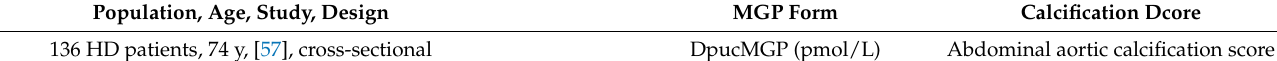
83 patients with CKD stages 3–5, 62.9 y, [77], cross-sectional